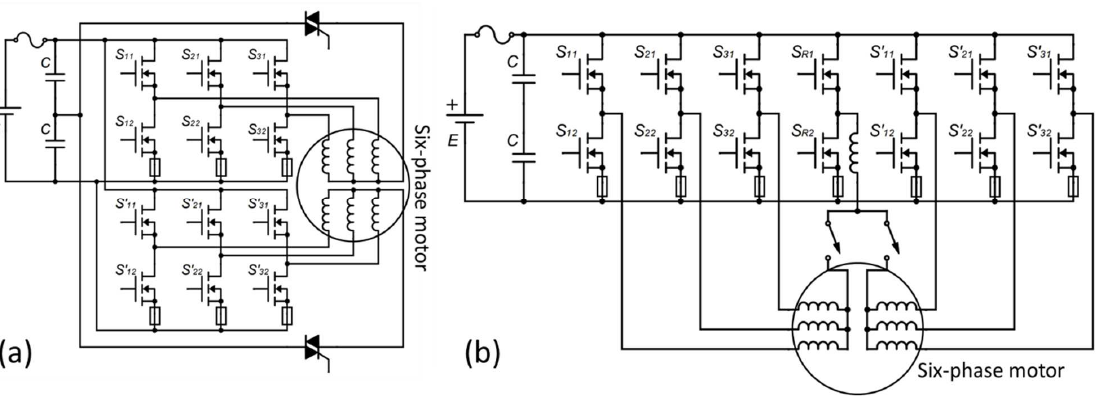
Figure 8. Dual-motor fault tolerant inverter topologies. ( a ) TPMO topology [61], ( b ) FLI topology [62].